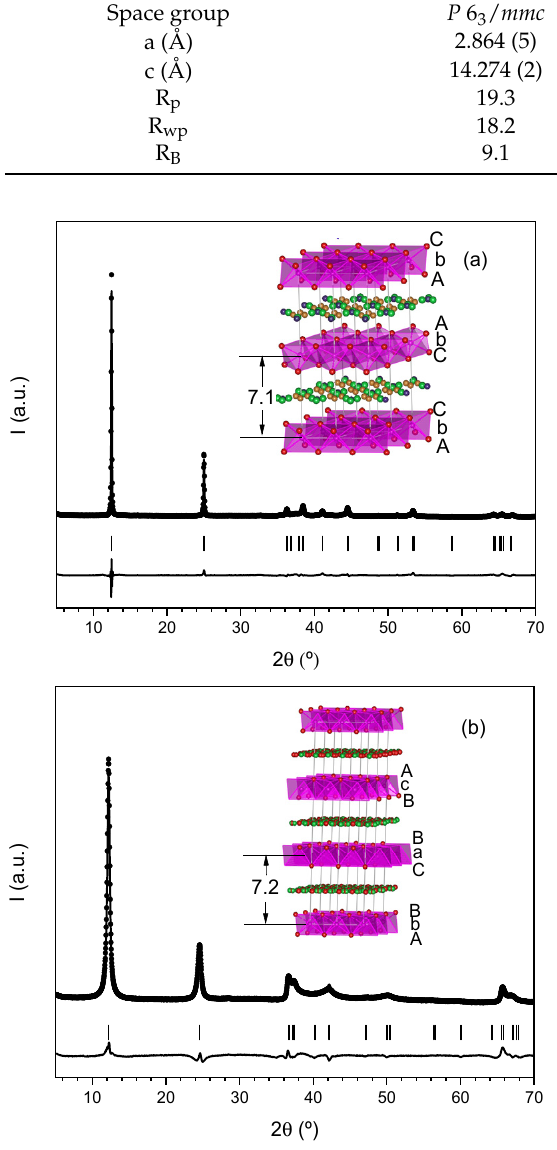
Figure 2. Calculated (line), experimental (dot) and difference (bottom line) Rietveld profiles for ( a ) KMn8 and ( b ) HKMn. Vertical bars indicate Bragg permitted reflections. Insets show corresponding structural models: layers of MnO 6 octahedra are represented in pink; water molecules and potassium cations are situated between layers.